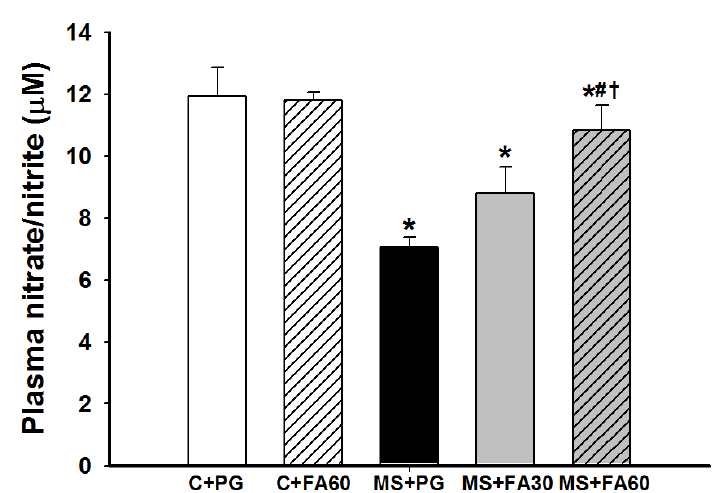
Figure 5. Effect of FA on plasma nitrate/nitrite levels in MS rats. Values are presented as mean ± standard error of the mean (SEM) ( n =8/group); * p < 0.05 vs. C + PG; # p < 0.05 vs. MS group; † p < 0.05 vs. MS with FA 30 mg/kg. FA, ferulic acid; MS, metabolic syndrome.